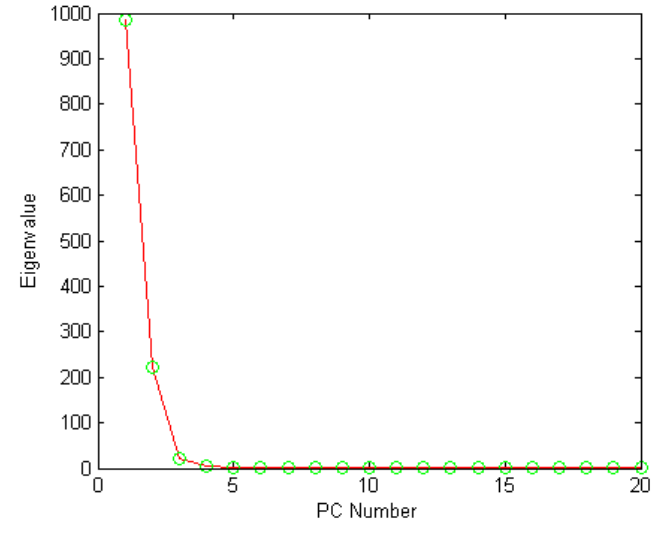
Figure 4. Eigenvalue of all the PCs.